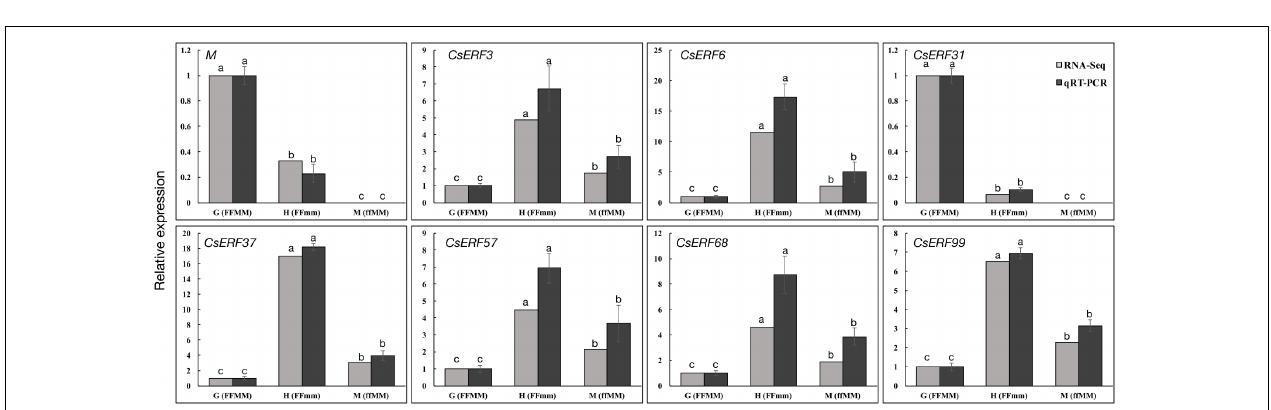
FIGURE 2 | Analysis to screening M -related genes from DEGs. Venn diagrams of DEGs that were upregulated (A) or downregulated (B) between different genotypes. Expression trend analysis of DEGs was performed to screen genes that have downregulated expression trends (Trend 1, 2, and 3) similar to M ( C , left) and upregulated trends (Trend 4 and 5) that are opposite. A total of 264 genes were classified into 5 trends and the best homolog was identified in Arabidopsis (C) ( Supplementary Table S4 ). The predicted protein interaction network (D) showed the homologs that were associated with ACS7, homolog of M ( D , left red box). The interaction network (E) showed the homologs that were associated with B-class floral protein (AP3 and PI) and shared opposite expression trend with M . In the network, the links between proteins signify the various interaction data supporting the network, colored by evidence type ( E , right inset). Information of genes presented in (D) and (E) are listed in Table 1 .